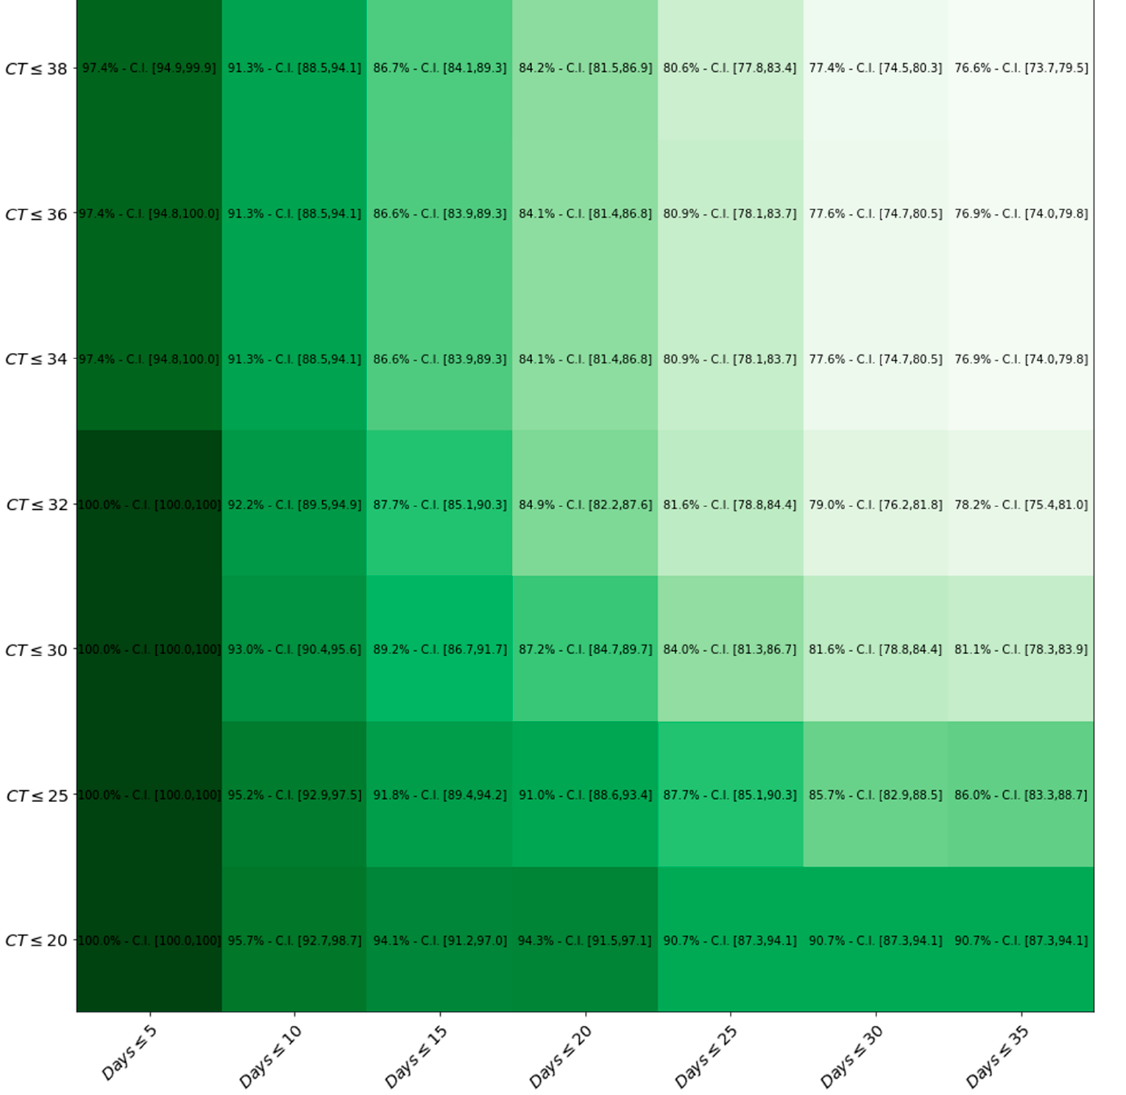
Figure 4. Heat-map displaying sensitivity with respect to both Ct values and Days after symptom onset thresholds. The darker the green, the higher the level of sensitivity of the LumiraDx TM compared to the gold standard RT-PCR.